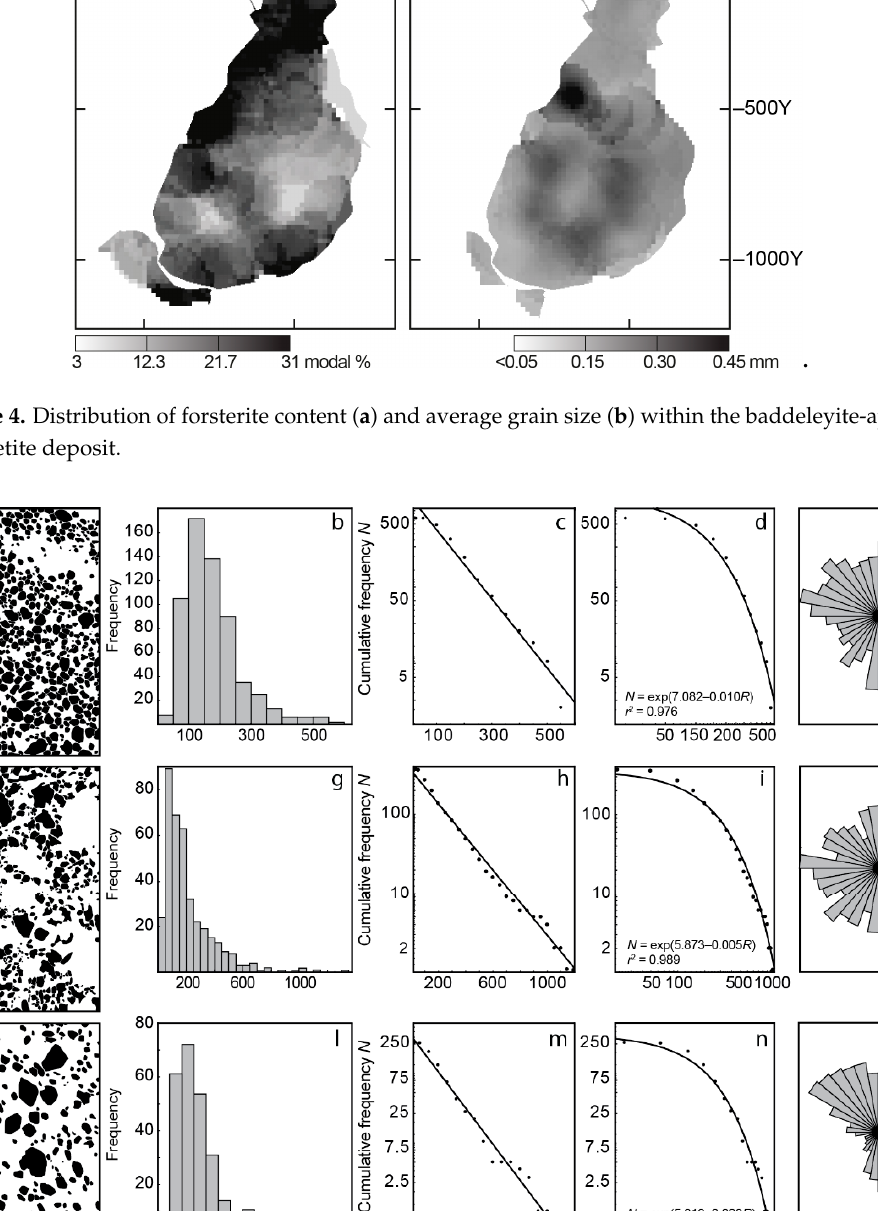
Figure 5. Grains of forsterite in thin sections of AF phoscorite 937/177.0 ( a ), MAF phoscorite 899/82.9 ( f ) and CMAF phoscorite 996/241.2 ( k ), corresponding histograms of equivalent circular diameter ( b , g , l ), cumulative frequency diagrams in semilog ( c , h , m ) and double logarithmic ( d , i , n ) coordinates, and orientation of elongated forsterite grains in the sections ( e , j , o ).